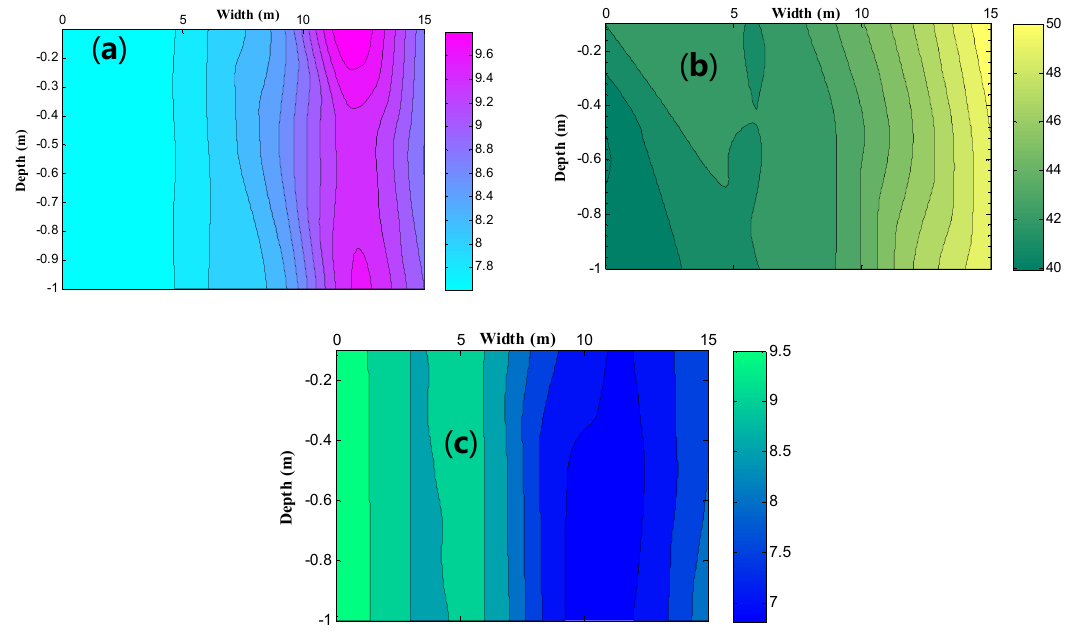
Figure 10. Cross-section maps of: ( a ) pH, ( b ) TDS, and ( c ) turbidity.